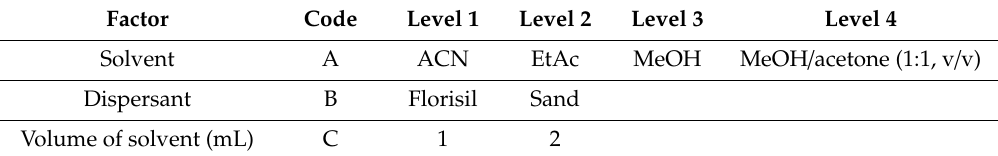
Table 2. Experimental factors and levels included in the experimental